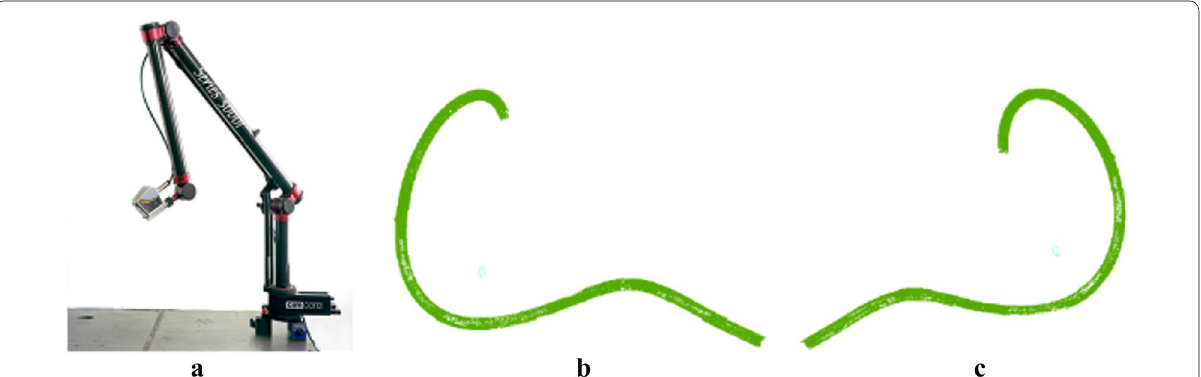
Figure 13 The reverse engineering for laying pipes: a laser scanning device; b the scanned laying pipe δ 2 ; c the scanned laying pipe δ 3